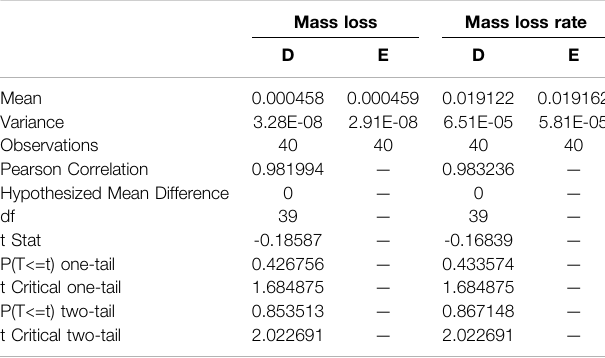
TABLE 2 | Paired two sample t -test (example for samples D and E).